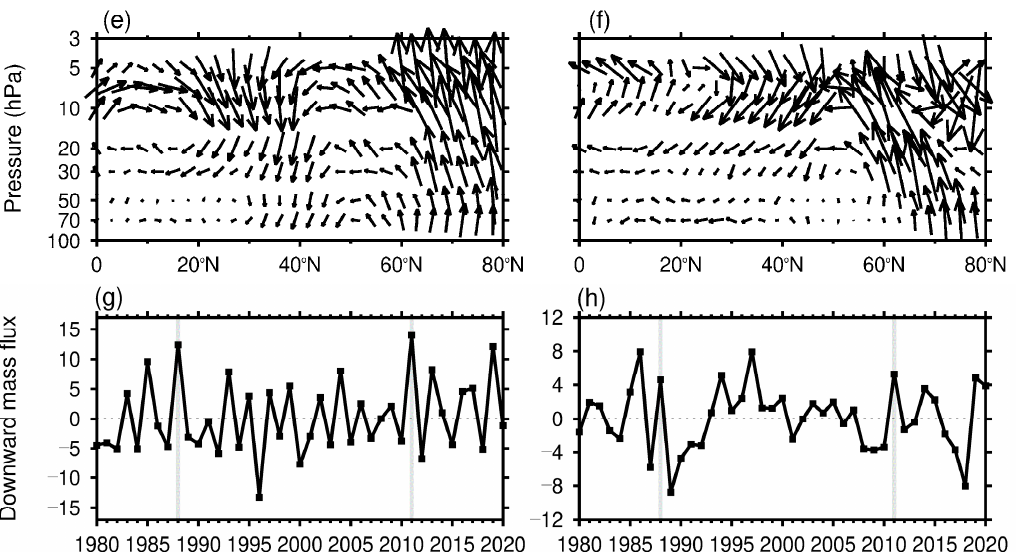
Figure 3. ( a , b ) Variation in HCl (black line) and N 2 O (red line) from ( a ) January 1987 to December 1988 and ( b ) January 2010 to December 2011 based on the SLIMCAT model simulation. ( c – f ) Latitude–height cross ‐ sections of the residual circulation anomaly averaged in ( c ) November–December 1987 and ( d ) November–December 2010; ( e ) January–February 1988 and ( f ) January–February 2011. The vertical component of the residual circulation was multiplied by 500. ( g , h ) Variations of ( g ) downward mass flux anomalies in the mid ‐ latitude upper stratosphere (5–10 hPa, 20–50°N) averaged for November–February and ( h ) upward mass flux anomalies in the high ‐ latitude lower stratosphere (20–50 hPa, 65–75°N) averaged for January–February from 1980 to 2020.